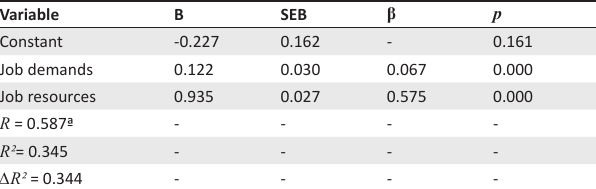
∆R² = 0.344 - - - - B, Unstandardised coefficient and constant for the linear regression equation; SEB, Standard Error of B; β , The standardised regression coefficient; p , probability value. N = 2429.